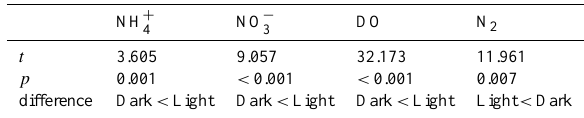
Table 3. Results from paired t test to determine differences in dark and light